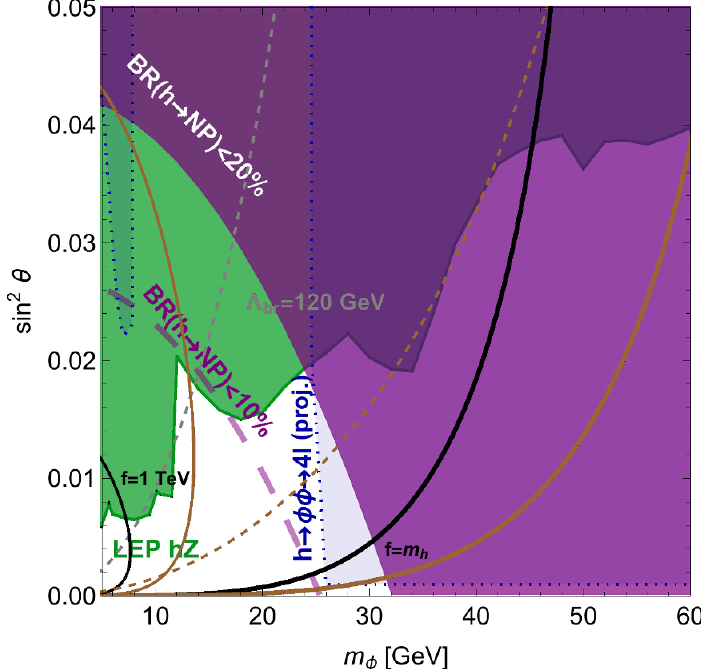
Figure 4 . Constraints on the relaxion-Higgs mixing sin 2 (cid:18) for relaxions with m (cid:30) between 5 GeV and 90 GeV from LEP and the LHC: 4-fermion (cid:12)nal states from Higgs strahlung at LEP (green, labelled as LEP hZ); Higgs decays to NP with BR( h ! NP) (cid:20) 20% at the LHC (purple, solid) as well as a projection for BR( h ! NP) (cid:20) 10% (purple, dashed); explicit searches for h ! (cid:30)(cid:30) with (cid:12)nal states 4 (cid:28) (dark blue, dotted, m (cid:30) < 10 GeV, Run 3 projection) and 2 (cid:22) 2 b (dark blue, dotted, m (cid:30) > 25 GeV, Run 3 projection). Contours for (cid:3) br = 120 GeV (gray, dashed for j = 2; brown, dashed for j = 1), f = m h and f = 1 TeV (black for j = 2, brown for j =